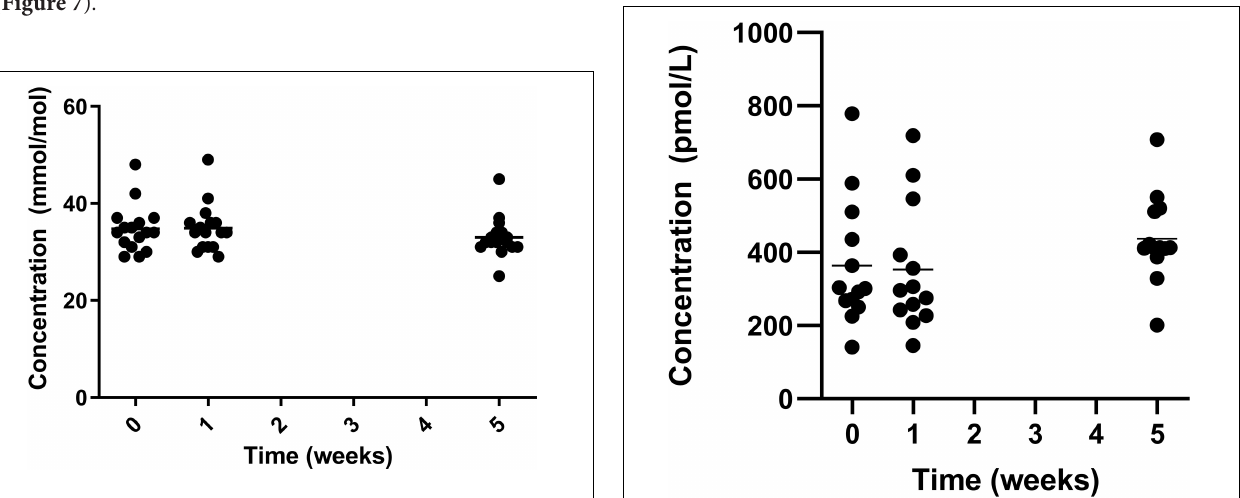
A significant increase was also seen in selenium from both week 0 and 1 to week 5 with the greatest increase coming from week 1 (1.14 ± 0.26 µ mol/L) to week 5 (1.40 ± 0.29 µ mol/L) ( Figure 8 ). Levels of potassium significantly decreased from both week 0 and week 1 to week 5, decreasing from 4.40 ± 0.31 mmol/L in week 0 and 4.41 ± 0.37 mmol/L in week 1 to 4.15 ± 0.28 mmol/L in week 5 ( Figure 9 ). The measurement at week 5 remained within normal range. From food diary data, micronutrient and energy intake was monitored and normalised for recommended intake across ages and sex ( Figure 10 ) (4) (the initial week vs 4 weeks of intervention). During the intervention, no one met their ) for the 19 participants FIGURE 5 | Circulating vitamin A ( • ) and vitamin E ( population level recommendation for energy intake with low who completed the study. The mean of each measurement shown as a solid (cid:35) intake of Huel servings. Despite low energy intake, intake of most black line. nutrients improved during the intervention in comparison